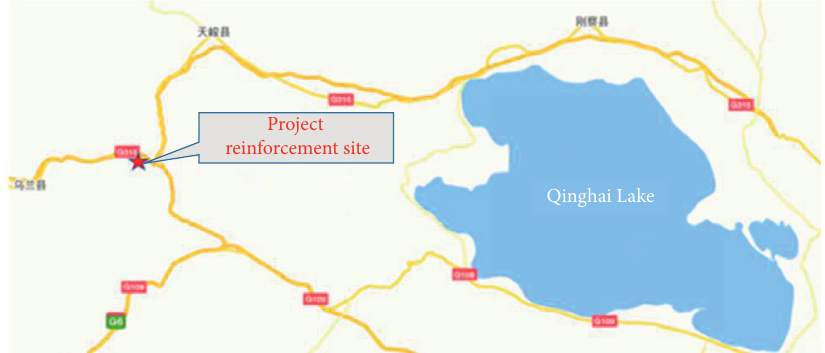
Figure 1: Project reinforcement site.